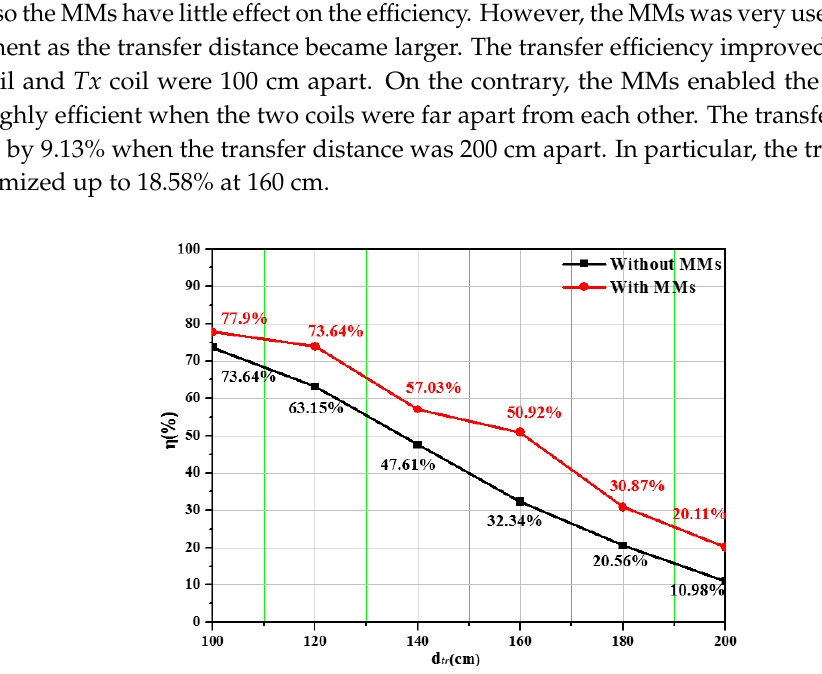
Figure 13. Effect of the MMs’ loading position on the system transmission efficiency.